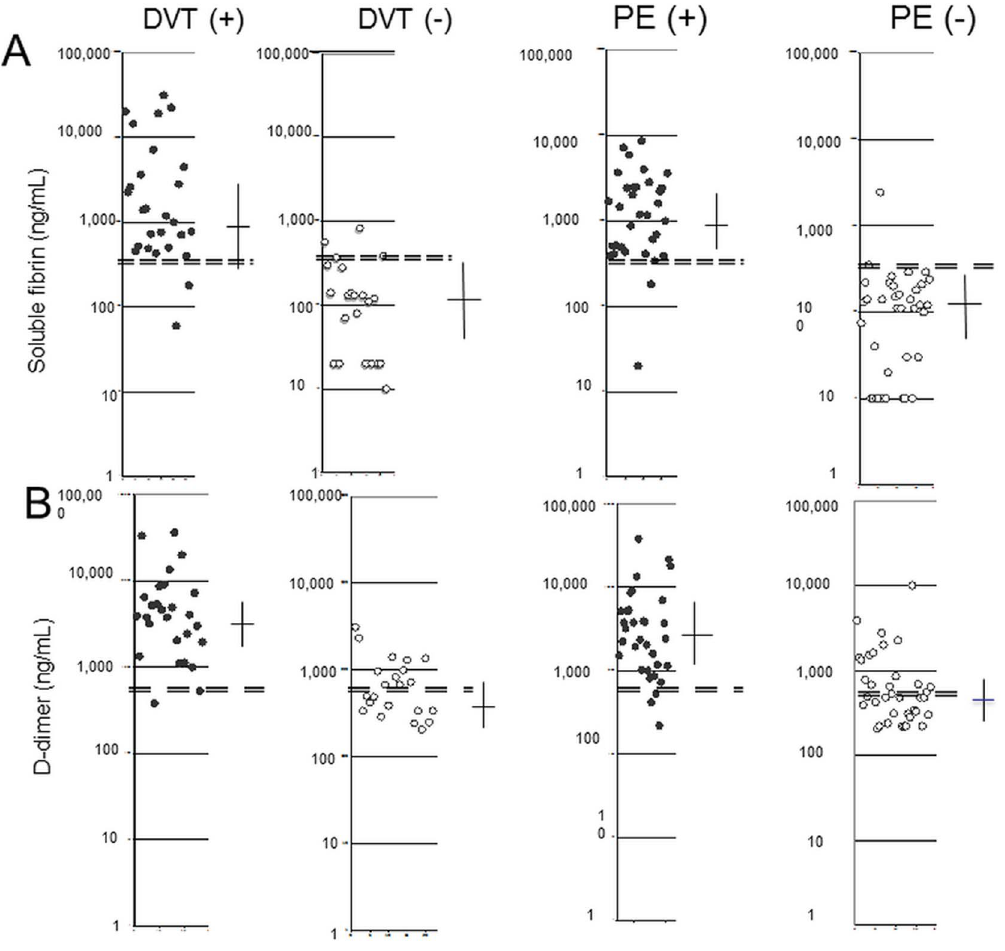
N /Closed circles: